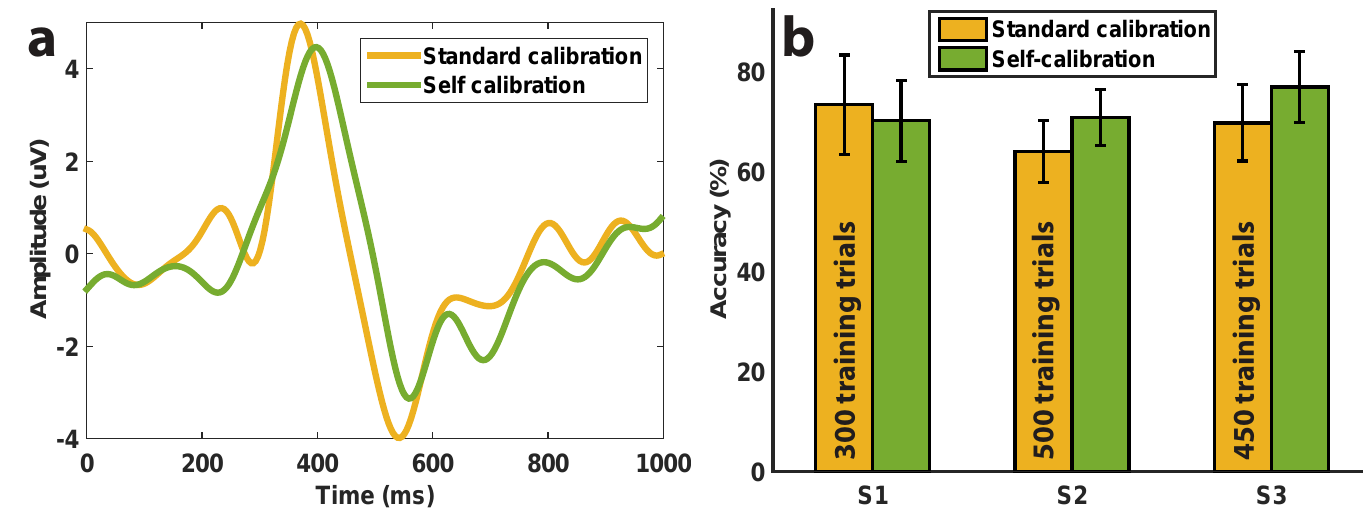
Fig 5. Signal and accuracy comparison with standard calibration. (a) Difference average (error minus correct grand averages) at channel FCz for the 3 subjects that performed the standard calibration and self-calibration protocols. (b) Online mean classification accuracy ( ± std) of the three subjects after following each calibration procedure, together with the number of calibration trials used for training in the standard calibration